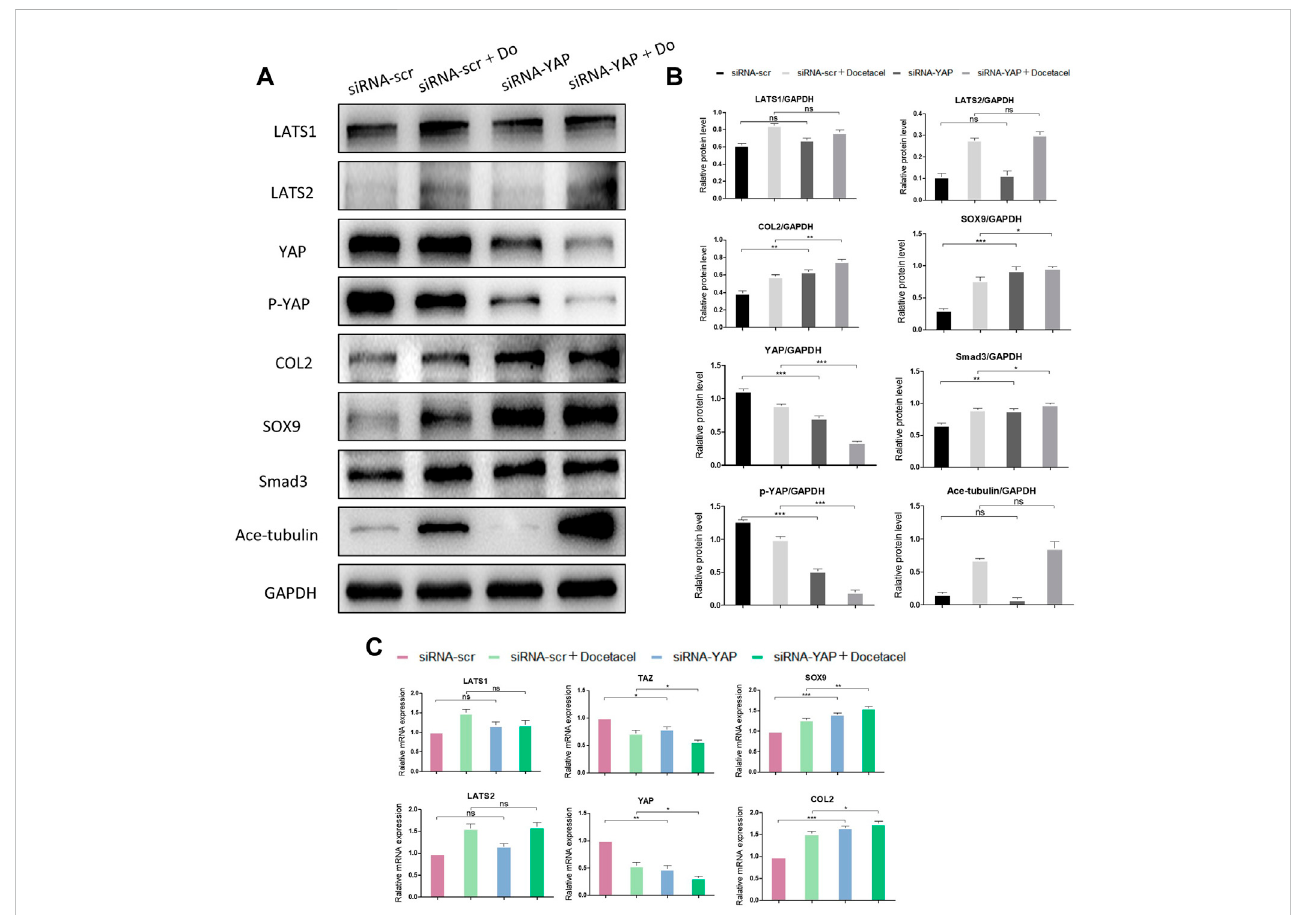
FIGURE 5 KnockdownofYAPpromotesthesynthesisofCOL2inNPcells. (A) WesternblotanalysisofAce-Tubulin,phosphorylated YAP,YAP,LATS1,LATS2,COL2, Smad3 and SOX9 in NP cells transfected with siRNA-YAP and treated with docetaxel for 1 week. (B) Quanti fi cation of the data of (A) . n = 4. (C) Q-PCR of YAP, TAZ, LATS1, LATS2, COL2, and SOX9 in NP cells transfected with siRNA-YAP and treated with docetaxel for 1 week. Data are represented as the mean ± SEM. * p < 0.05, ** p < 0.01, *** p <